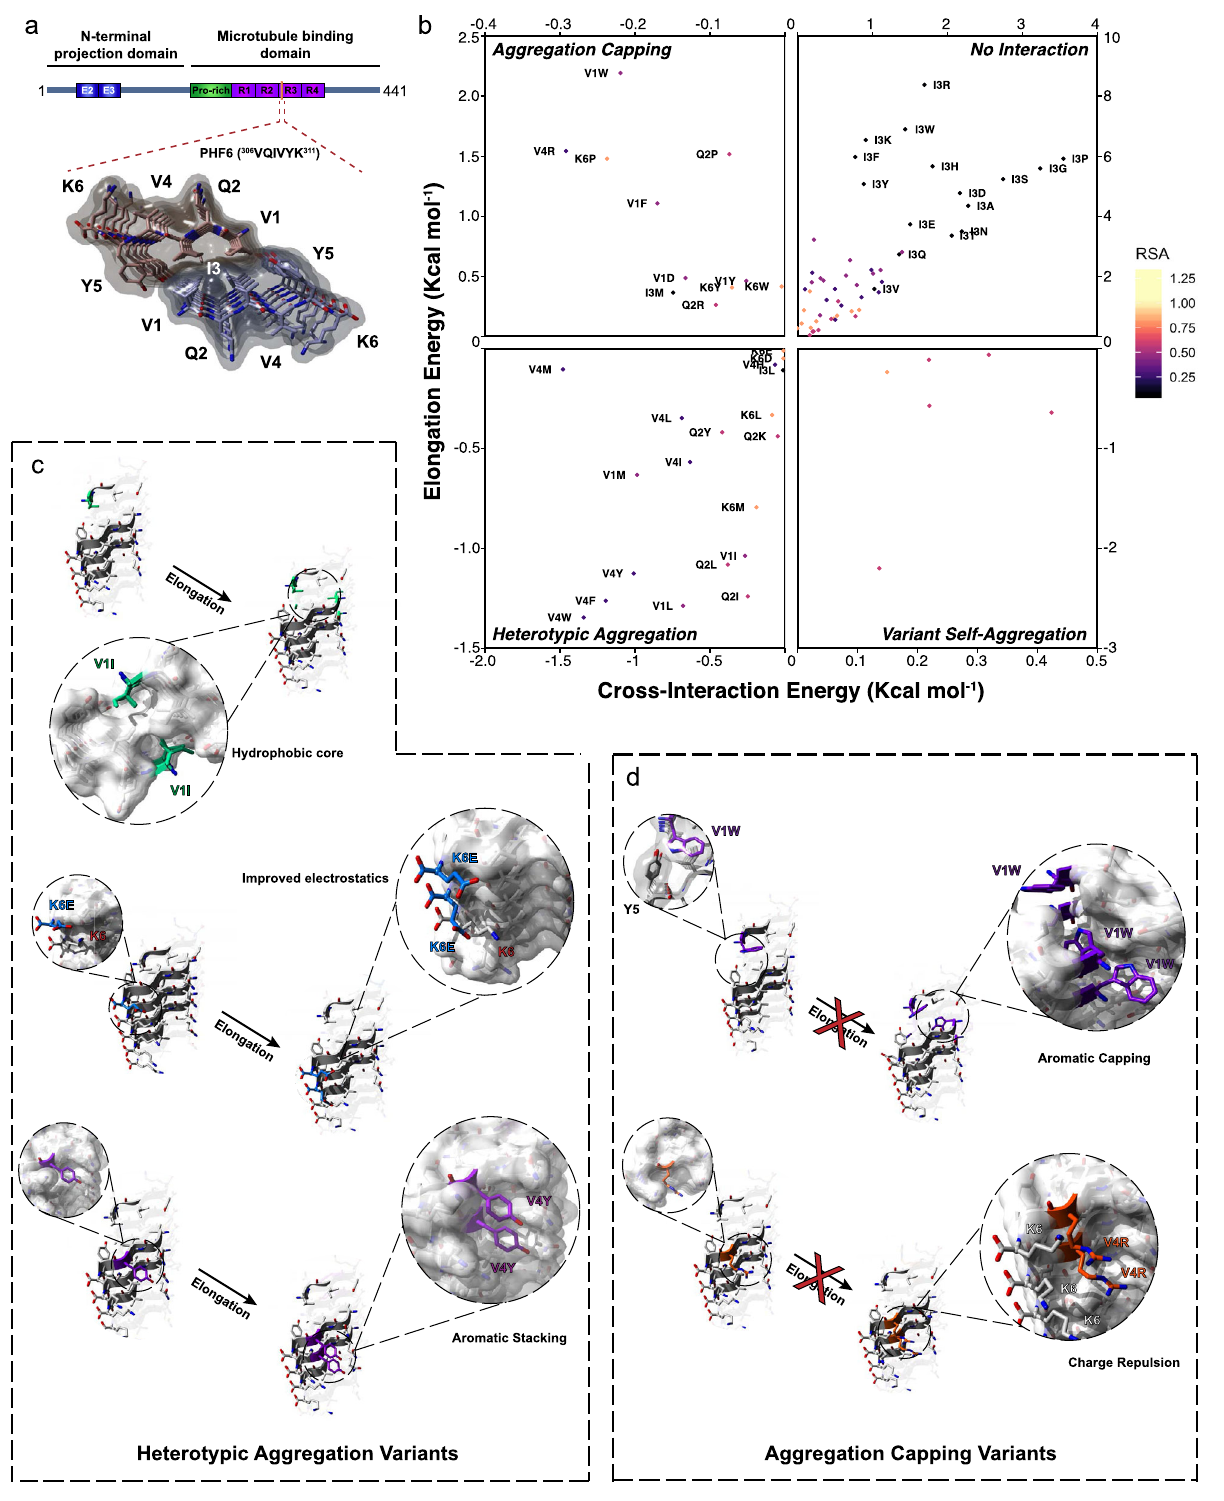
Fig. 4 Thermodynamic pro fi ling of cross-interactions for the VQIVYK amyloid core. a Schematic representation and positioning of the VQIVYK APR in full-length tau. b Quadrant plot analysis of the four modes of interactions for single variants of the VQIVYK APR. c Heterotypic aggregation is promoted by hydrophobic mutations that stabilise the aggregation core, electrostatic interactions that improve surface solubility or improved stacking interactions at the exposed fi bril surface. d Capping interactions are facilitated by the incorporation of bulky aromatic residues that blocked further elongation at the fi bril tips through steric clashes or charged side chains that blocked elongation through electrostatic repulsion of stacked